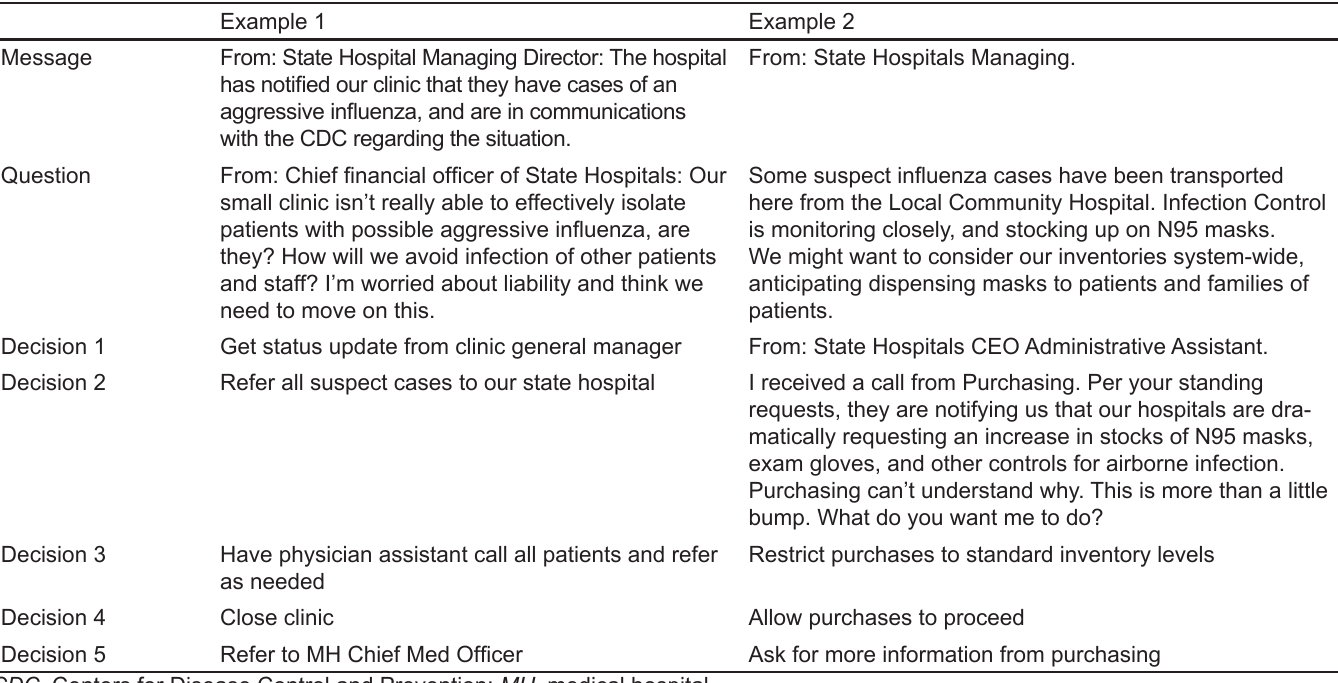
Table 6. Examples of key decisions made by hospital chief executive officer (CEO).